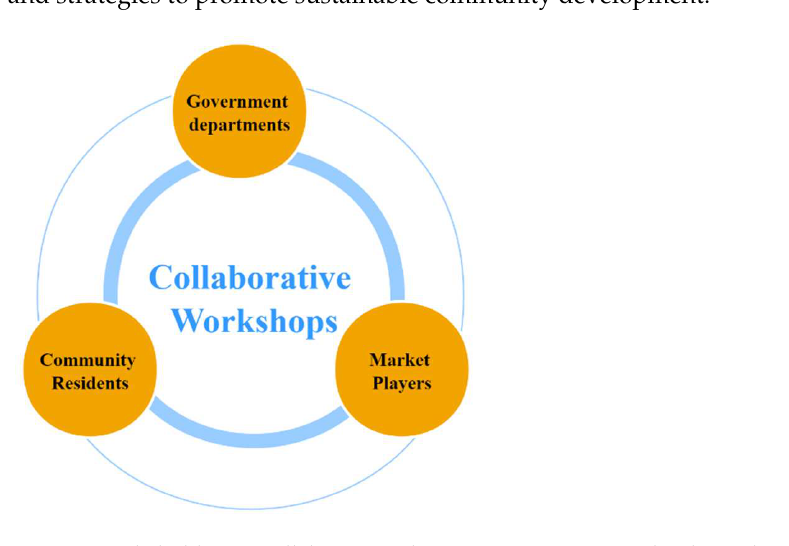
Figure 1. Stakeholders in collaborative planning. Source: Drawn by the authors.